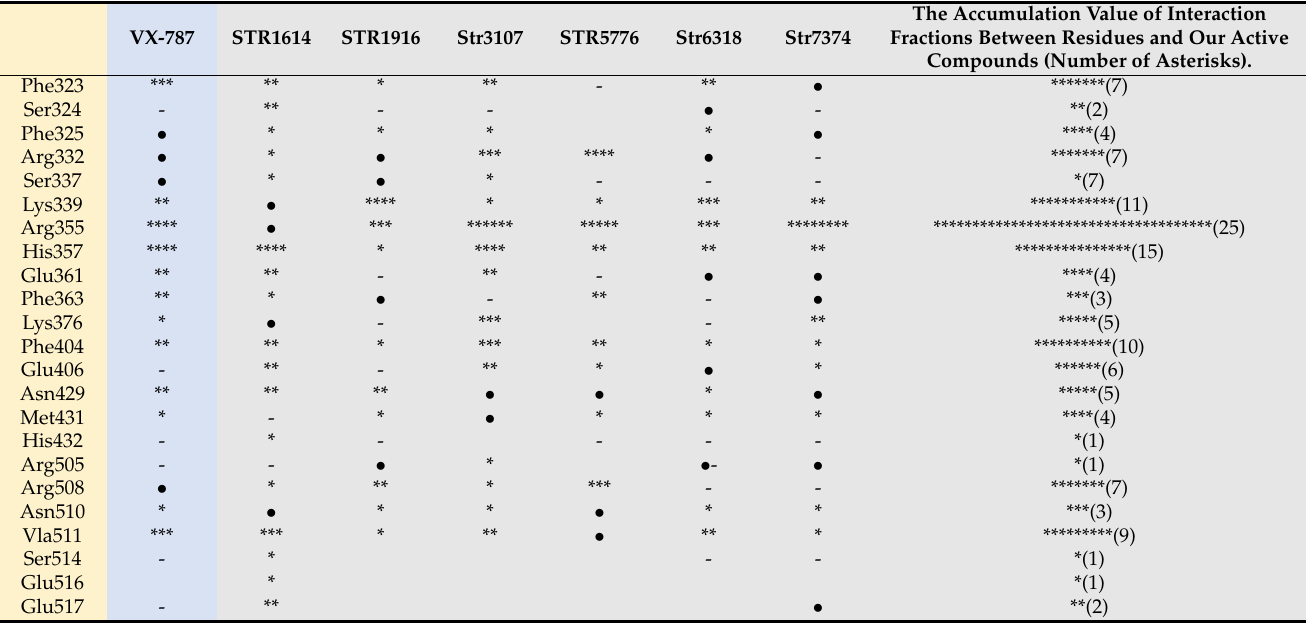
A dash (-) indicates that the residue is not in contact with the ligand, a dot ( • ) indicates that the interaction fraction of the residue and the ligand is between 0 and 0.1, and an asterisk (*) indicates that the interaction fraction of the residue and the ligand is between 0.1 and 0.5. Multiple asterisks indicate that the interaction score between the residue and the ligand is greater than 0.5, and an asterisk is added for every increase of 0.5 in the interaction fraction value. The cumulative value of the interaction scores between different residues and our six active compounds are shown in the last column, represented as one asterisk or multiple